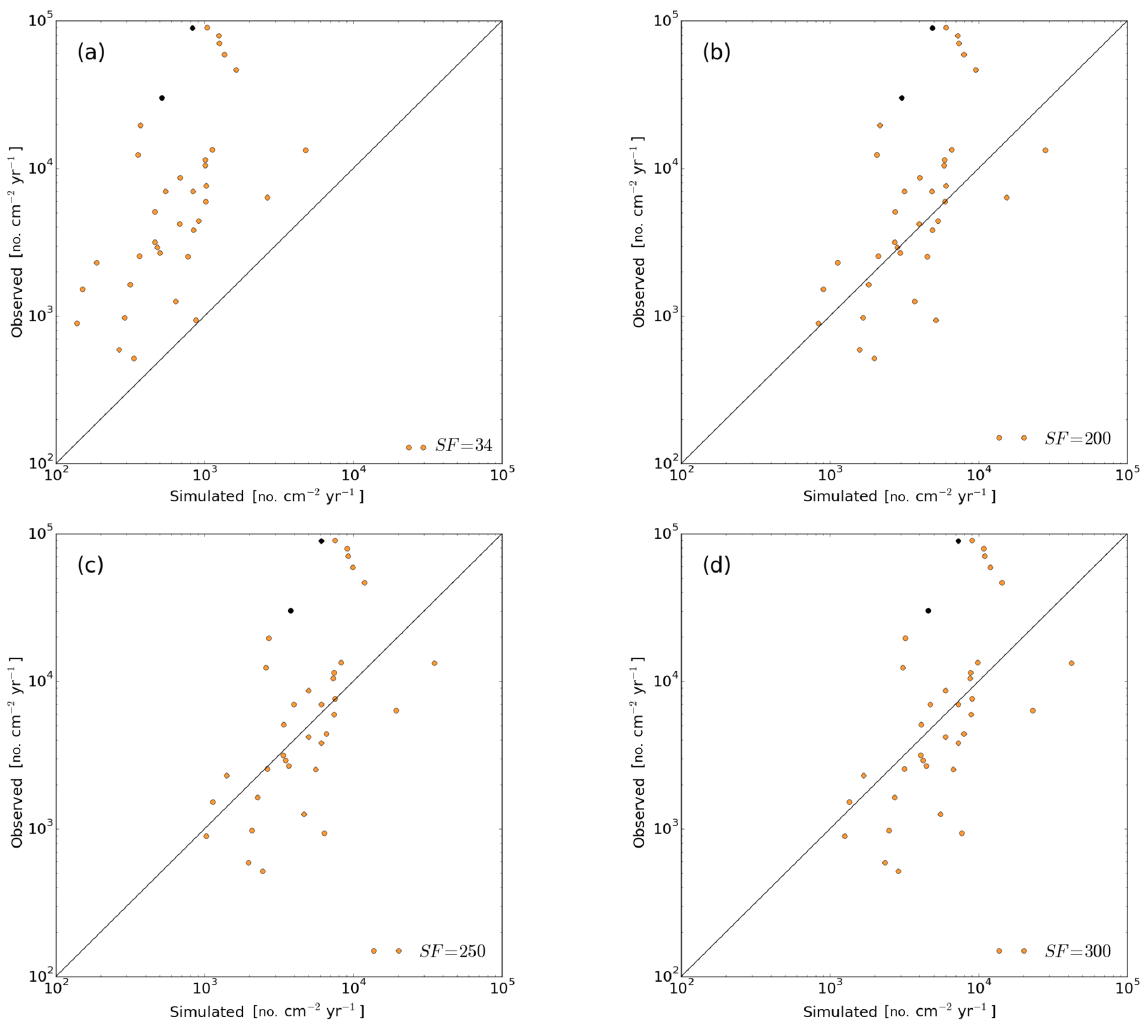
Figure 1. Simulated vs. observed number fluxes of charcoal particles above the threshold radius (in cm − 2 yr − 1 ) using the chosen estimate of parameters (an emission number geometric mean radius of r eq = 5 µm, a threshold radius of r eq = 4 . 9 µm, and a charcoal density of 0 . 6 g cm − 3 ). The scaling factor increases from (a) to (d) (see legends). The two black dots show the sites likely influenced by surface